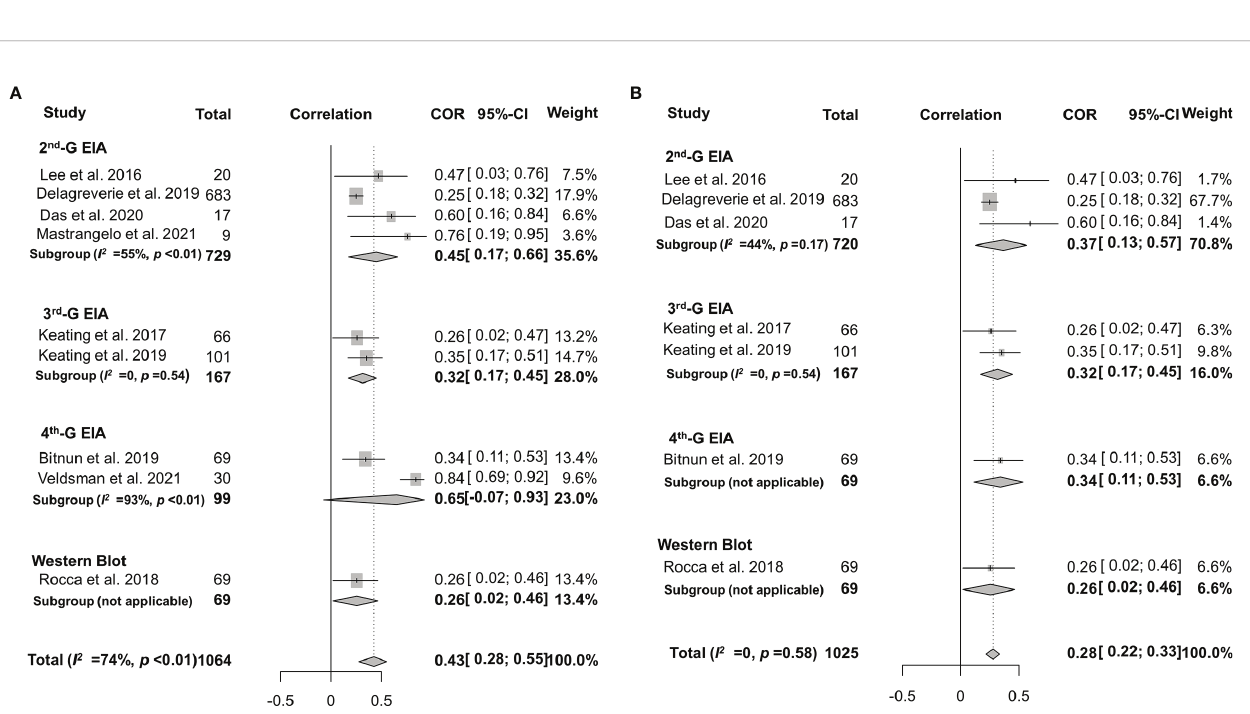
FIGURE 7 | Forest plots of the pooled Spearman ’ s correlation coef fi cient (rho) with the corresponding 95% CIs for the correlation between HIV-1-speci fi c antibody titer and HIV-1 DNA burden among HIV-infected population according to the serological test principles for all the eligible studies (A) or the studies without signi fi cant heterogeneity (B) .